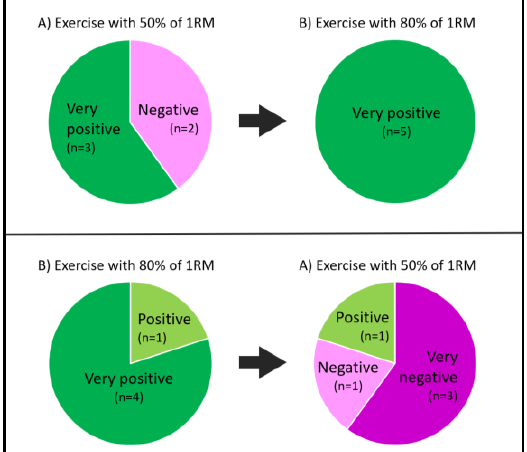
Figure 1. Participants’ experiences and group differences of the resistance exercise session starting with ( A ) 50% of 1RM followed by ( B ) 80% of 1RM versus starting with ( B ) 80% of 1RM followed by ( A ) 50% of 1RM. (1RM = One Repetition Maximum).